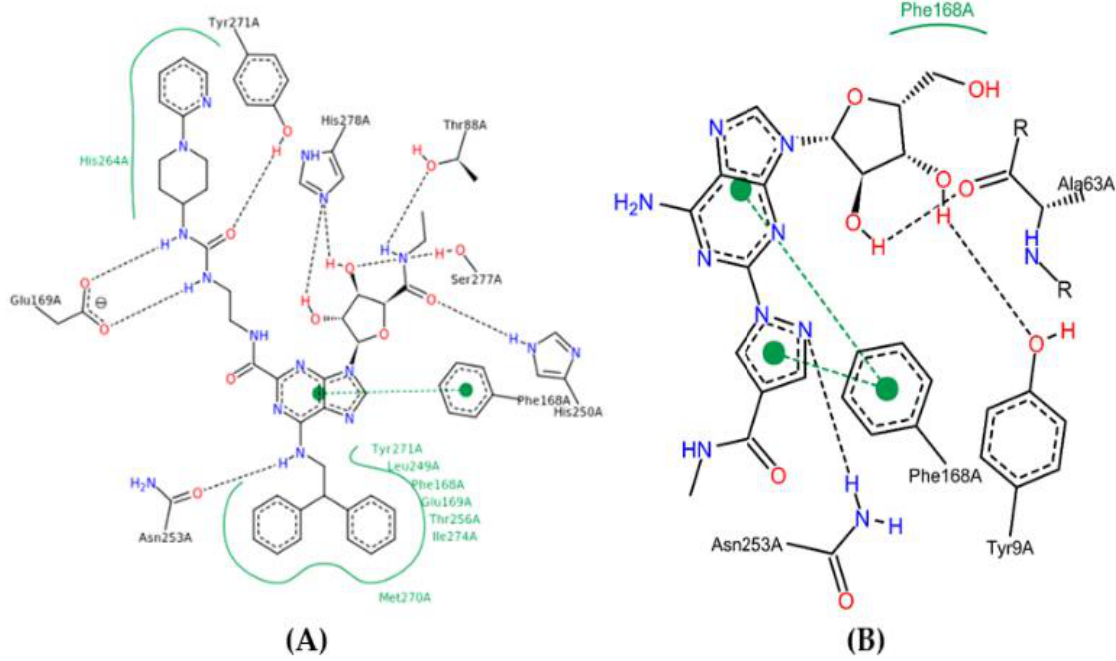
Figure 8. Binding profile of UK-432097 ( A ) and Regadenoson compound ( B ) with A 2A AR. Figure